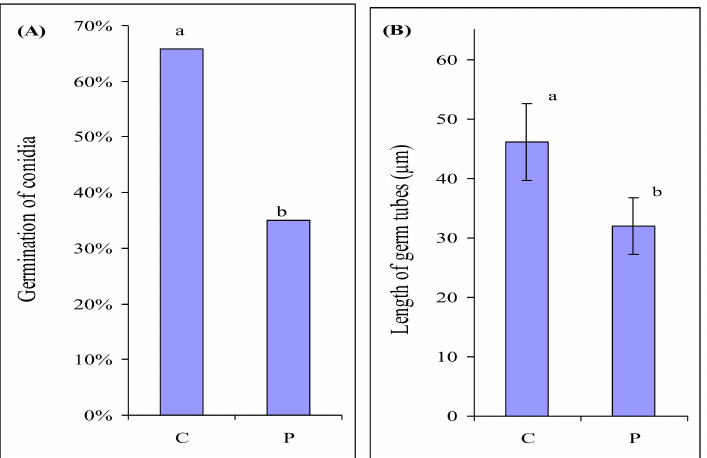
Figure 3. Germination of Fusarium culmorum macroconidia ( A ), length of germ tubes of F. culmorum macroconidia ( B ) after 6 h of incubation in the mineral medium in the absence (C) and presence of P. fluorescens (P). n = 300 macroconidia. Significant di ff erences in germination of macroconidia were analyzed using Mann–Whitney U-test. Error bars show standard deviation. Values of di ff erent letters are significantly di ff erent at p ≤ 0.05 when applying Fisher’s LSD test, and at p ≤ 0.01 when applying Mann–Whitney